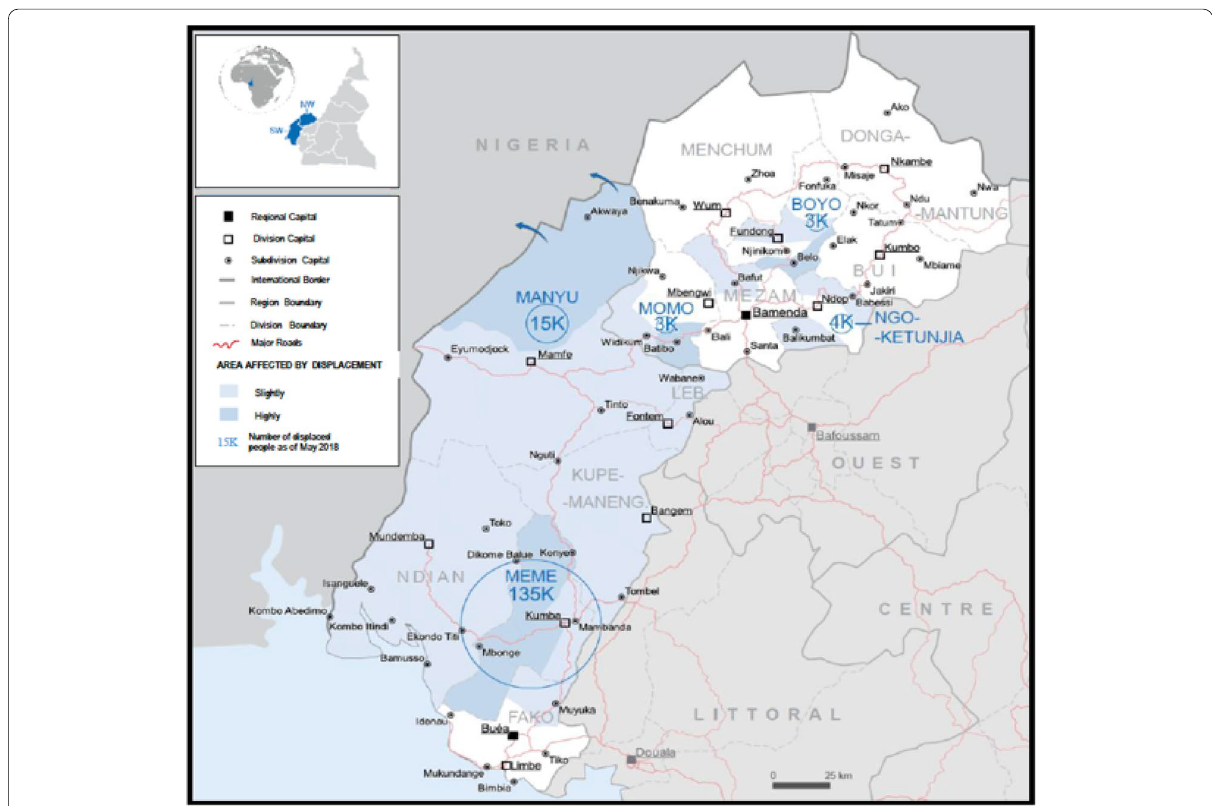
Fig. 3 Map of the North West Region and South West Region showing areas most affected by population displacement. Source: adapted from UNOCHA